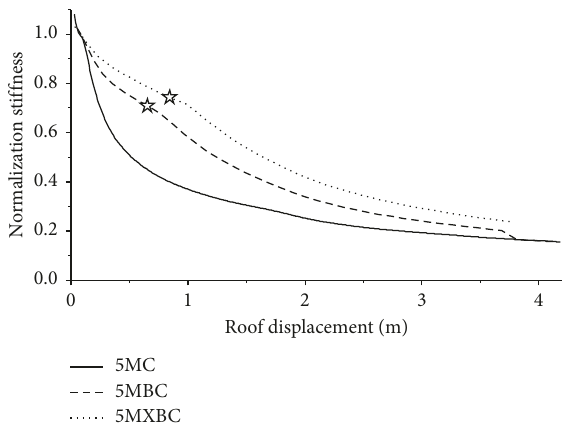
Figure 20: The normalization stiffness curves of three model